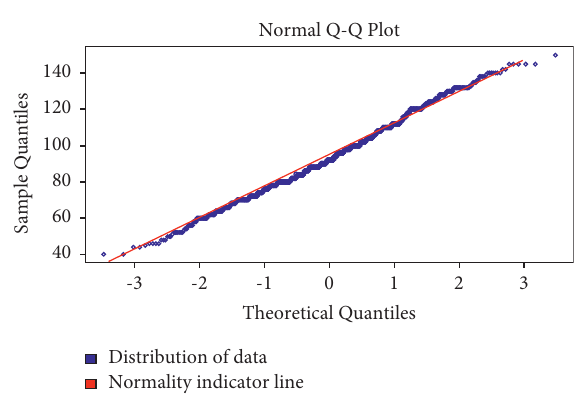
Figure 1: Normal Q-Q plot of the pulse rate for heart failure patients.